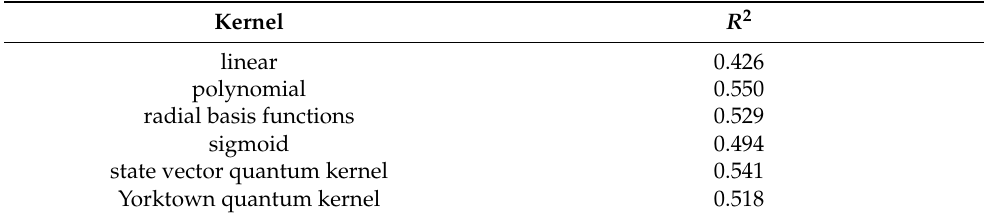
Table 1. Weighted out-of-sample R 2 for the classical and quantum kernels.